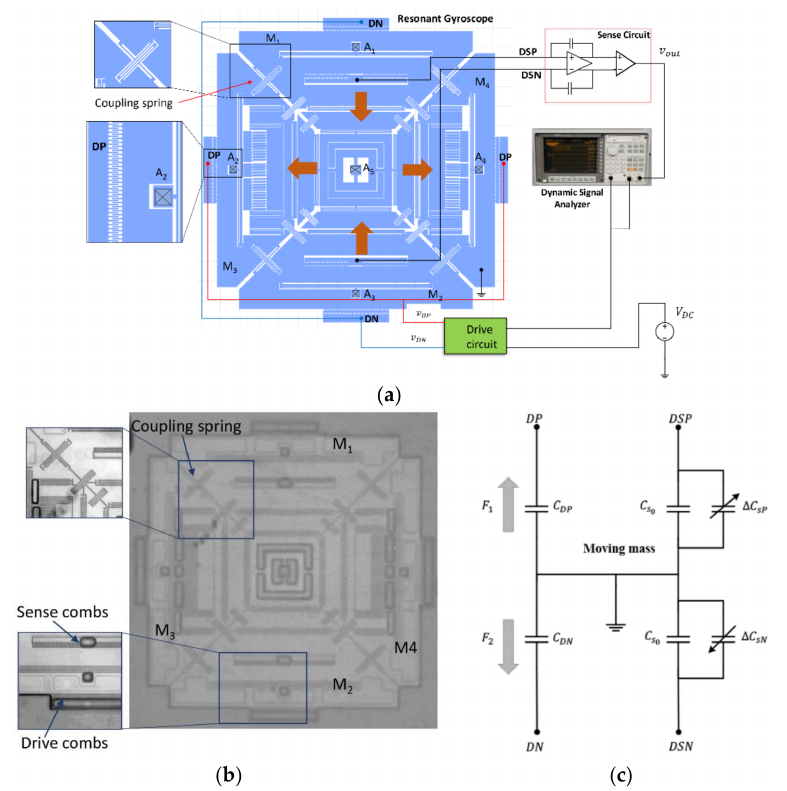
Figure 1. ( a ) Experimental setup for resonant characteristics measurement of the MEMS resonator. ( b ) Optical photograph of the vacuum packaged single structure 3-axis gyroscope. ( c ) Electrical model of the MEMS resonator.